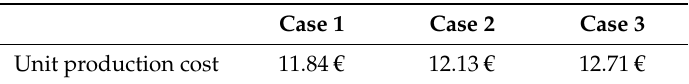
Table 2. Unit production costs.